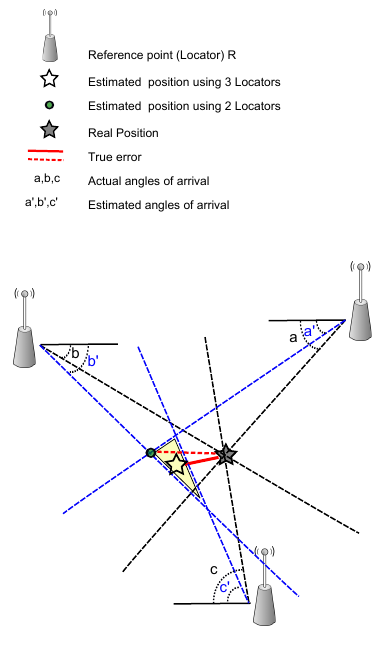
Figure 4. Angle of arrival (AOA)-based